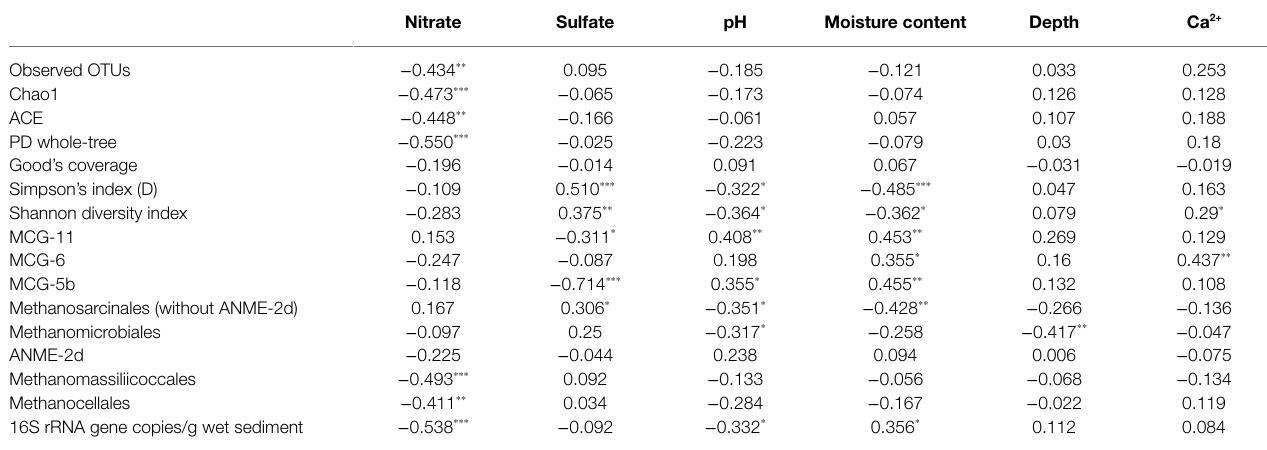
TABLE 2 | Spearman correlation analysis between physicochemical parameters and alpha diversity indices, major euryarchaeotal orders, bathyarchaeotal subgroup proportions and 16S rRNA gene abundances.